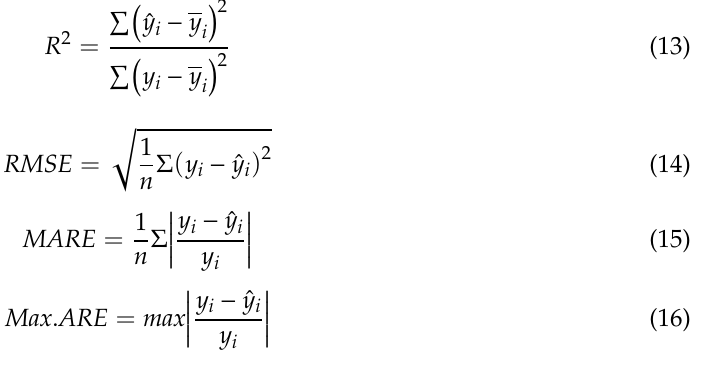
Table 2. Numerical validation for the training and test